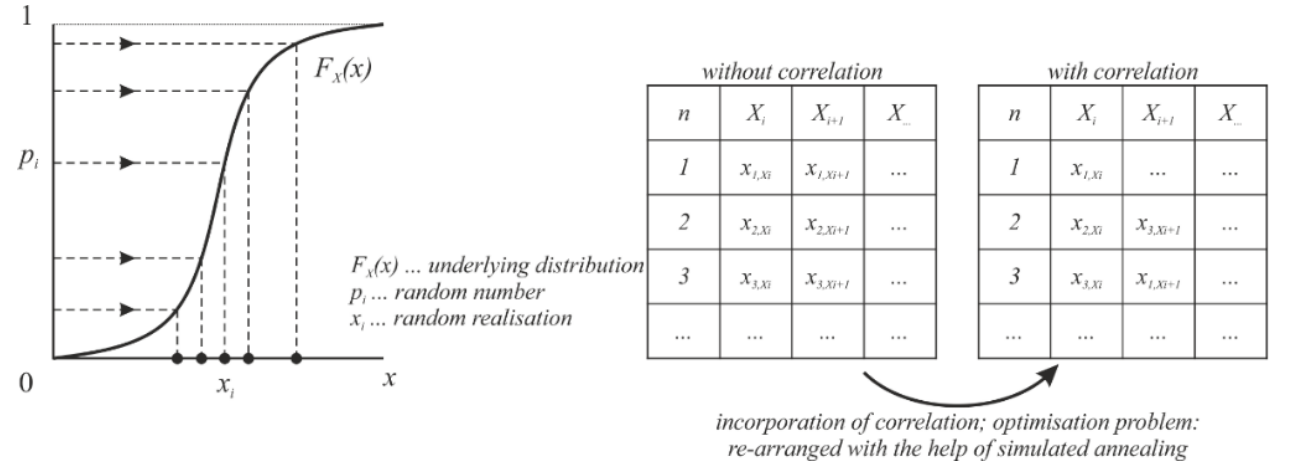
Figure 1. Monte-Carlo method simulation procedure including and not including correlation between basic variables.